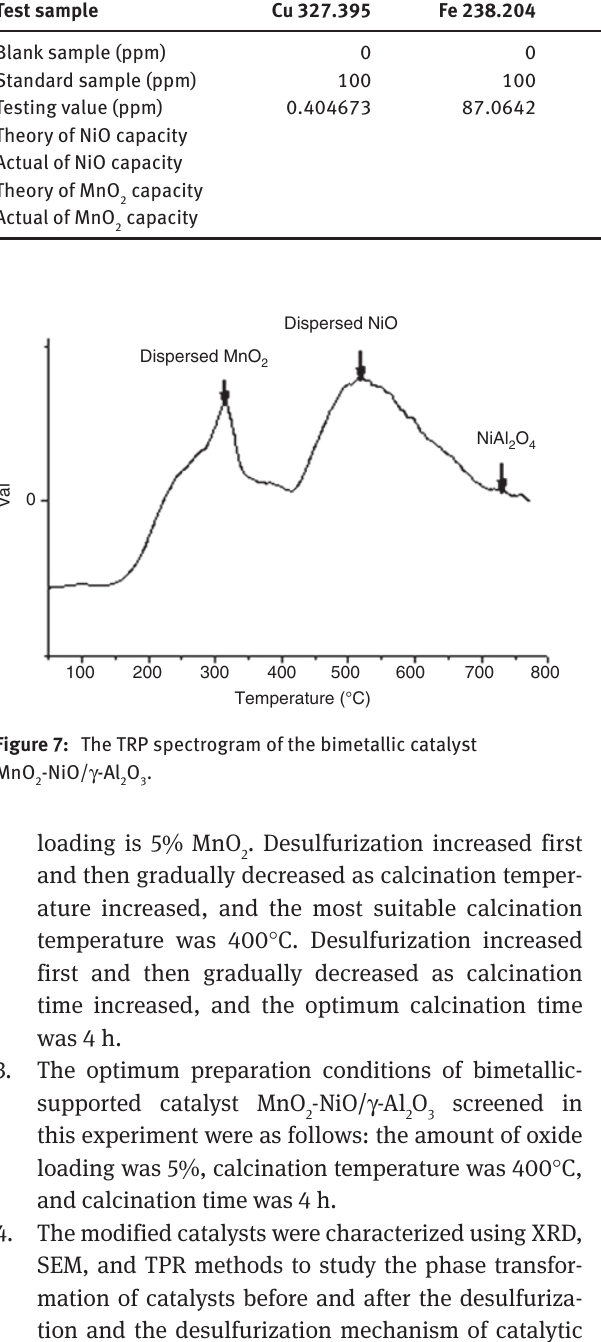
Table 1: The testing result of ICP. Test sample